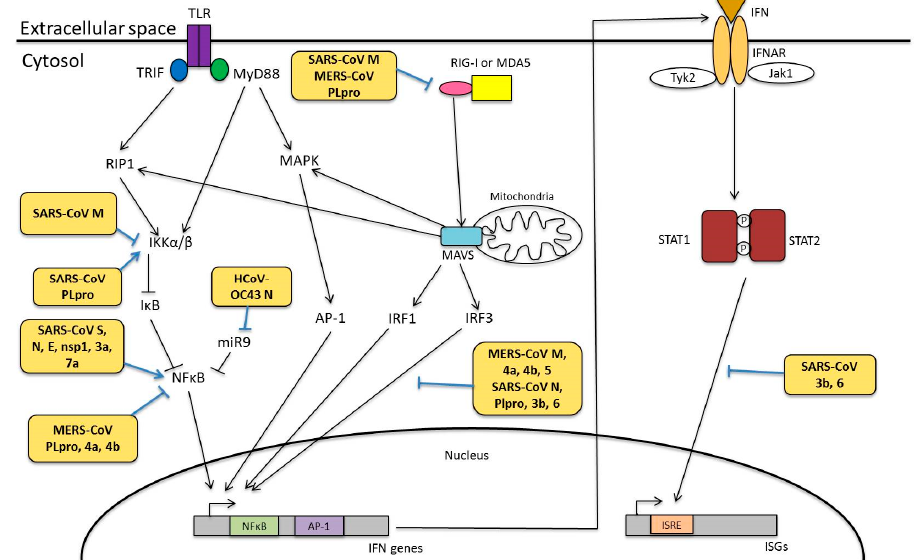
Figure 5. HCoV viral proteins on innate immunity. During HCoV infection, PRRs such as TLRs, RIG-I and MDA5 are activated to trigger a series of signalling pathway, including MAPK and NF- κ B, for IFN production. These IFNs then act on IFNAR and activate the JAK-STAT signalling pathway to induce ISGs. The yellow-orange boxes show the viral proteins that have been reported to modulate host innate immunity at multiple stages.